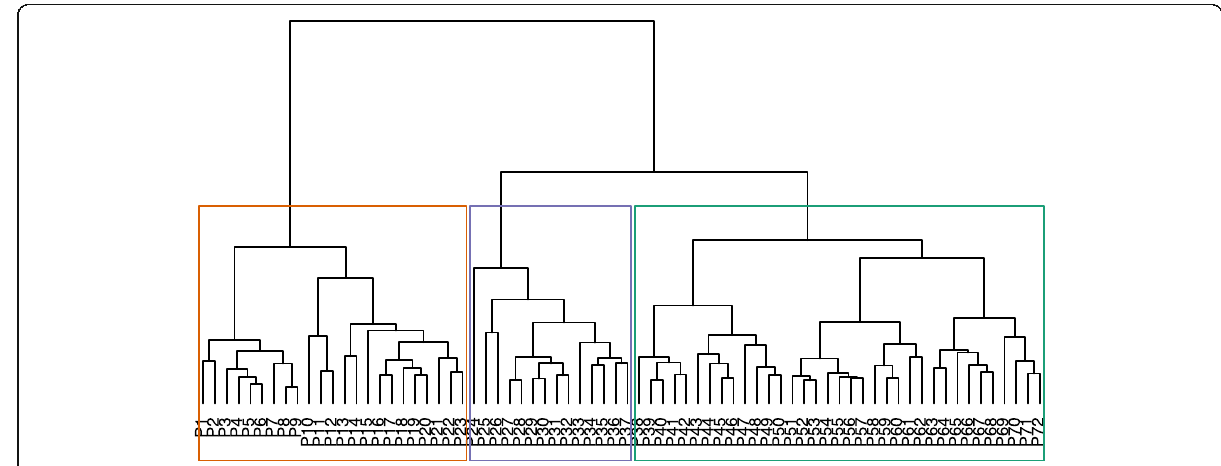
Fig. 5 Dendrogram showing the hierarchical structure of the observed physics mini studios (combined tutorials and